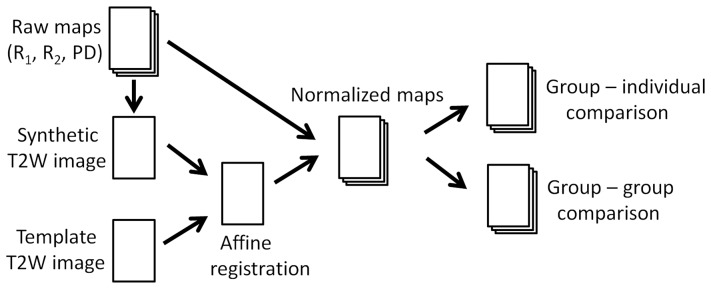
Schematic overview of the method.Magnetic Resonance quantification maps of R1 and R2 relaxation rates and proton density (PD) are used to synthesize a T2-weighted image. This image is normalized against a standard template T2-weighted image using affine registration. The same transformation is used to normalize the R1, R2 and PD maps. The individual quantitative maps from a group of subjects are averaged to obtain reference maps of typical cerebral tissue parameters. Such reference maps can either be compared to an individual brain or with another group.